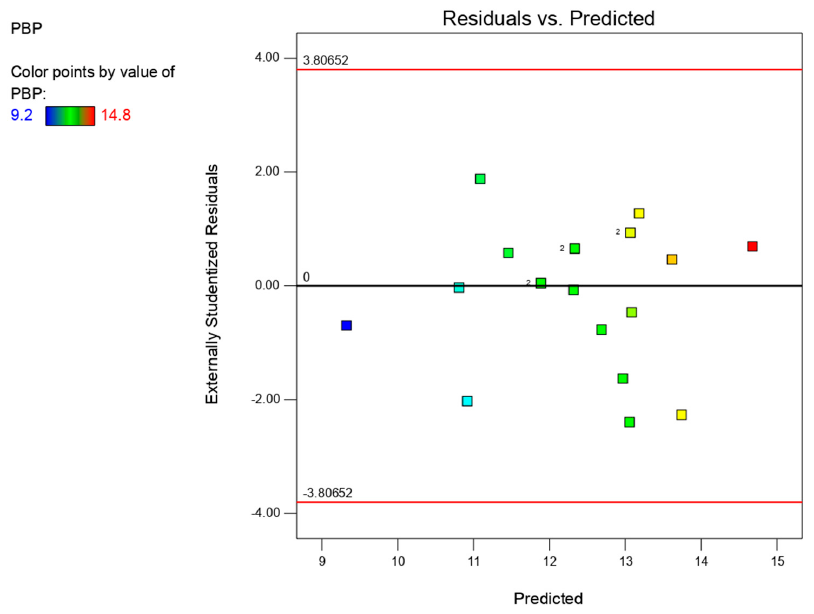
Figure 7. Plot of residuals vs. predicted PBP response data.